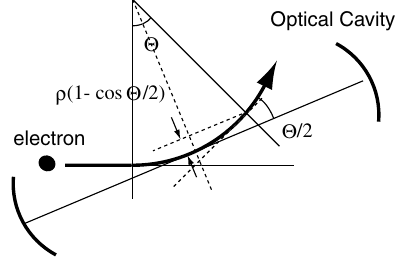
FIG. 3. Schematic of the orbit of the electron in the bending magnet equipped with the optical cavity.